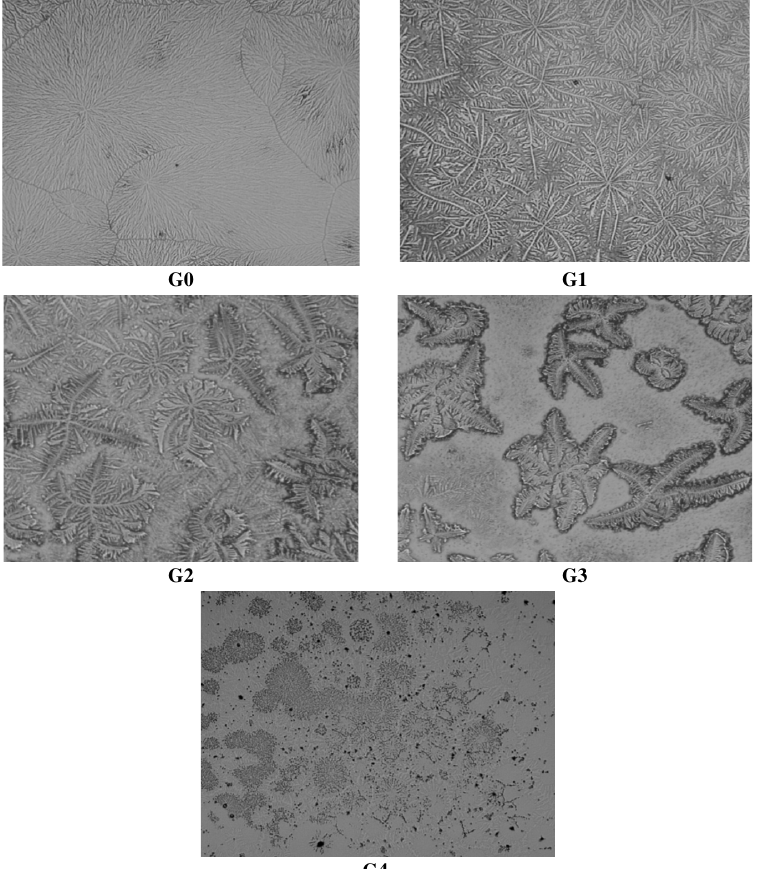
Fig. 1. The recently developed TF grading scale (grades 0 – 4).